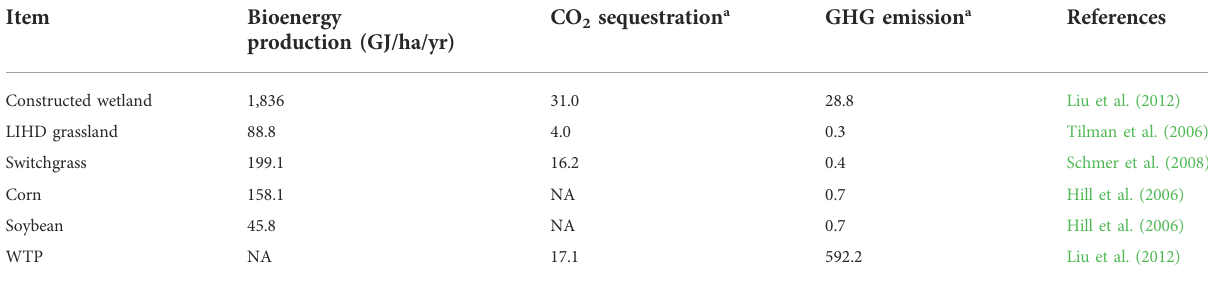
TABLE 6 Comparison of production in terms of biofuel ecosystems. Item